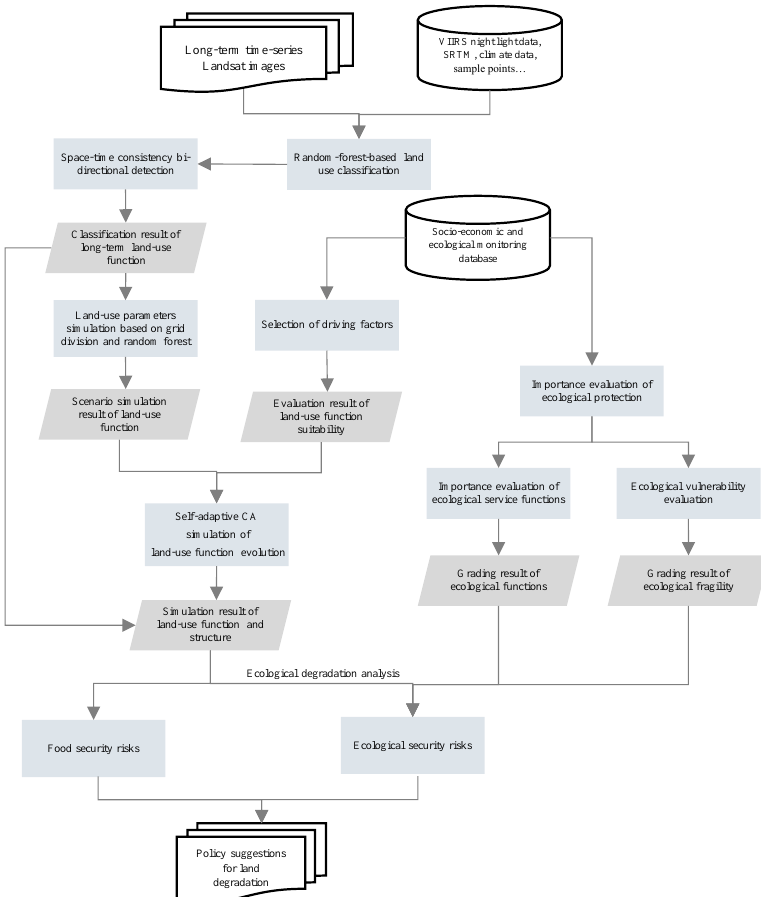
Figure 2. The main technical flows adopted in the methodology.